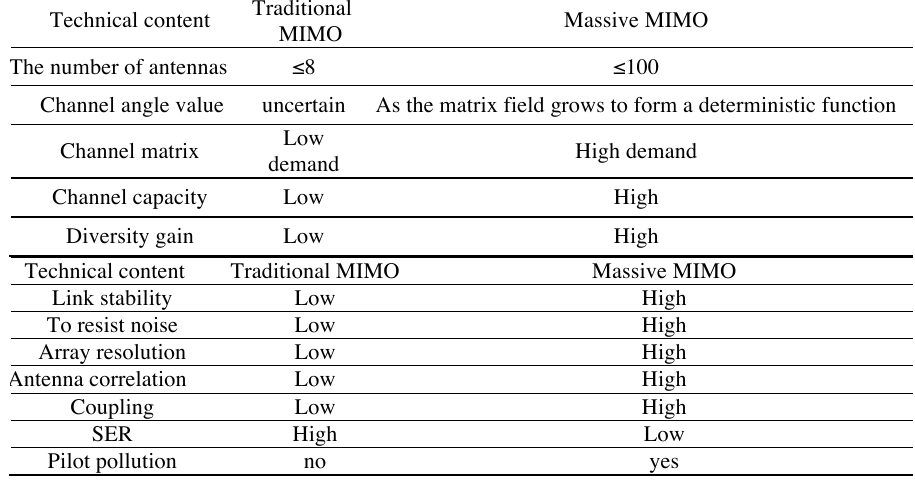
Fig. 3. The basic model of massive MIMO.